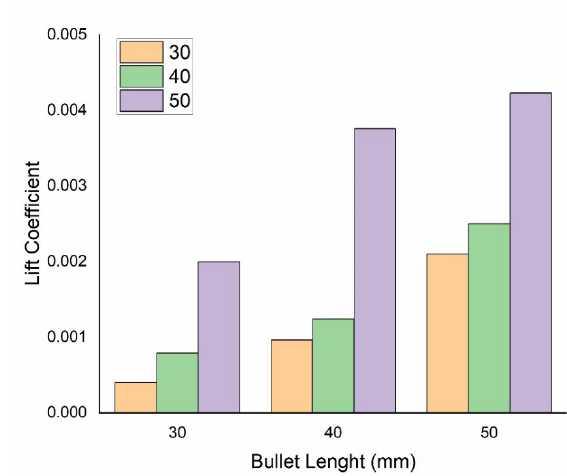
Figure 9. Simulated values of lift coefficient of 30 mm, 40 mm, and 50 mm bullet heads (design I) at 30°,40°,and 50° angle of attack.